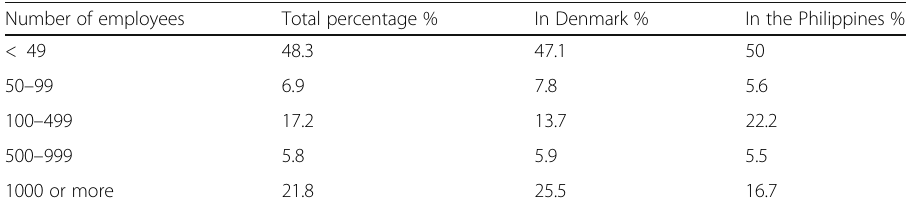
Table 3 Size of retail stores Number of